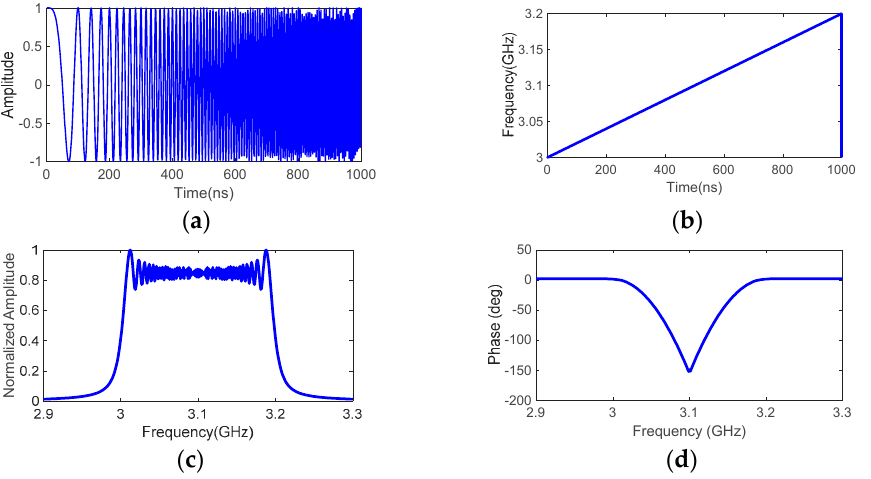
Figure 7. Transmitted FMCW signal that was used in the measurement: ( a ) time domain, ( b ) time- frequency domain, frequency domain ( c ) amplitude, and ( d ) phase.